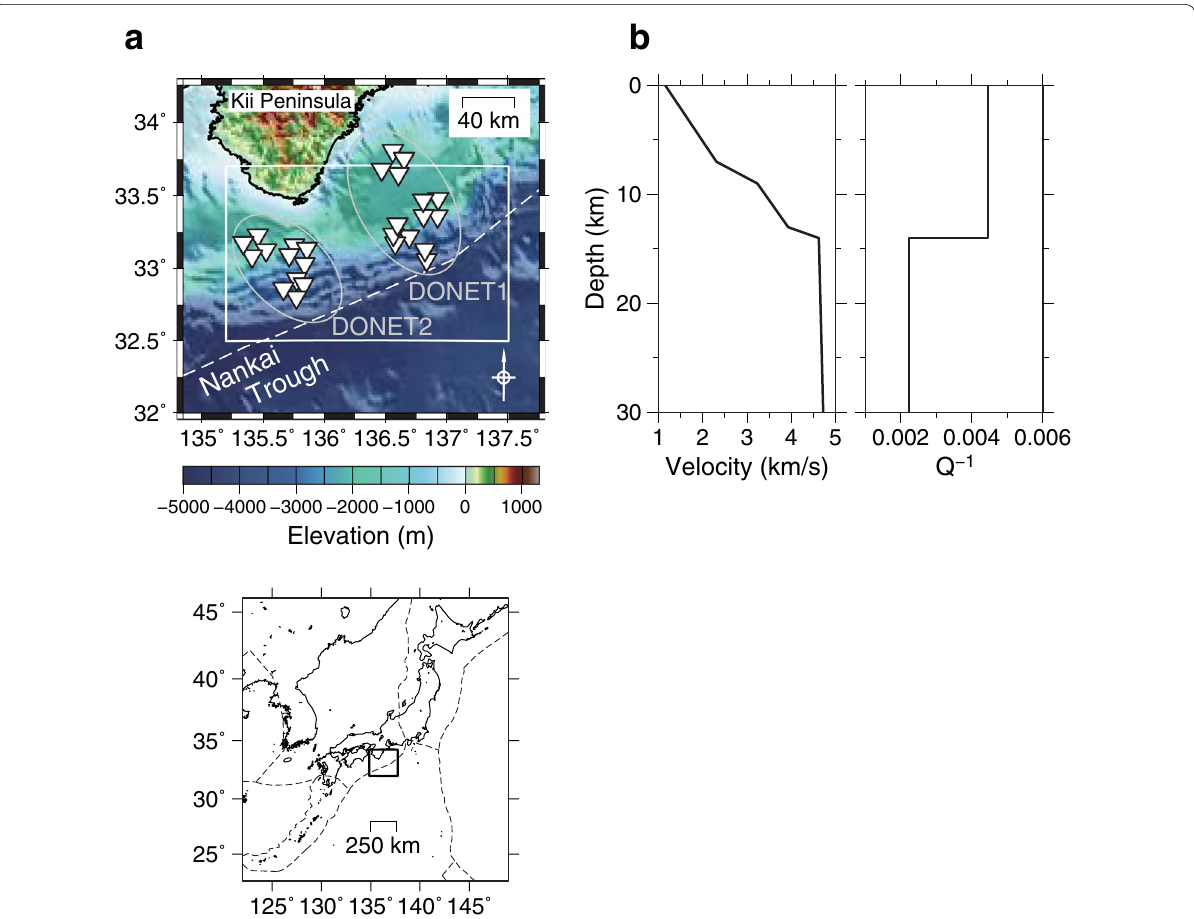
Fig. 1 a Regional (bottom) and location (top) maps of the study area and the distribution of DONET seismic stations (white inverted triangles). White rectangle shows the region of our grid search. Topography is from the ETOPO1 model (NOAA National Centers for Environmental Information 2009) and plate boundaries are from Bird (2003). b Depth-dependent 1-D S-wave velocity (left) and attenuation (right) structures used in this